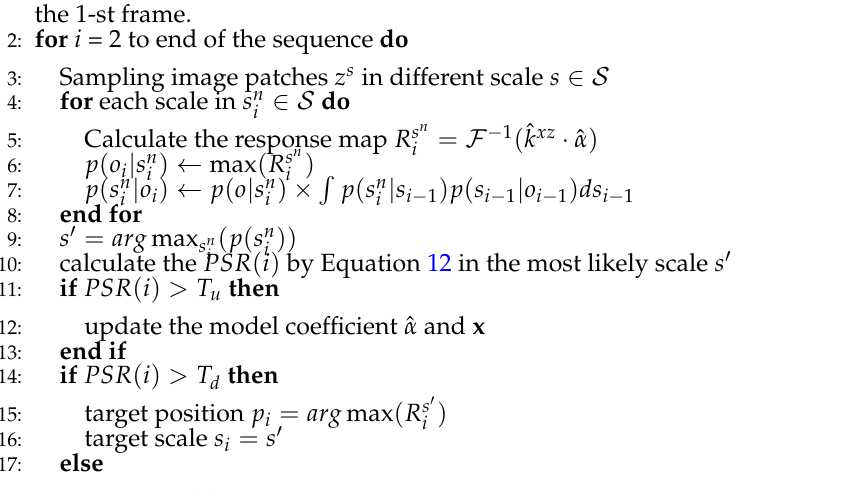
Algorithm 1 Proposed Tracking